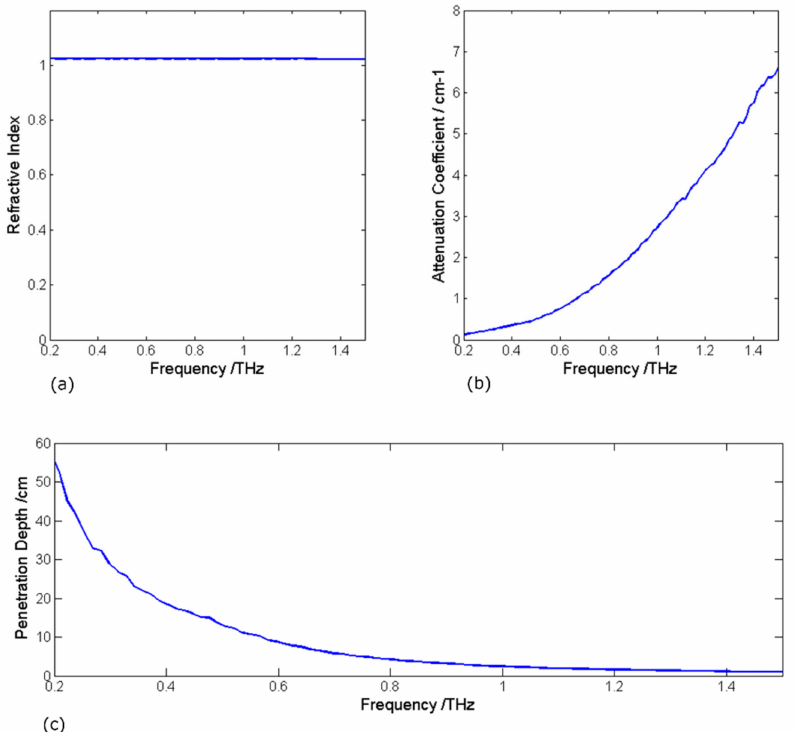
Figure 2. ( a ) Refractive index of insulating foam, with a constant refractive index of 1.02 up to 1.5 THz; ( b ) Attenuation coe ffi cient, which is low compared to many materials, rising with frequency primarily due to scattering; ( c ) Presents the penetration depth for the system SNR of almost 1000:1 indicating that lower frequencies < 0.5 THz are best for penetrating the insulation of the order of tens of centimeters